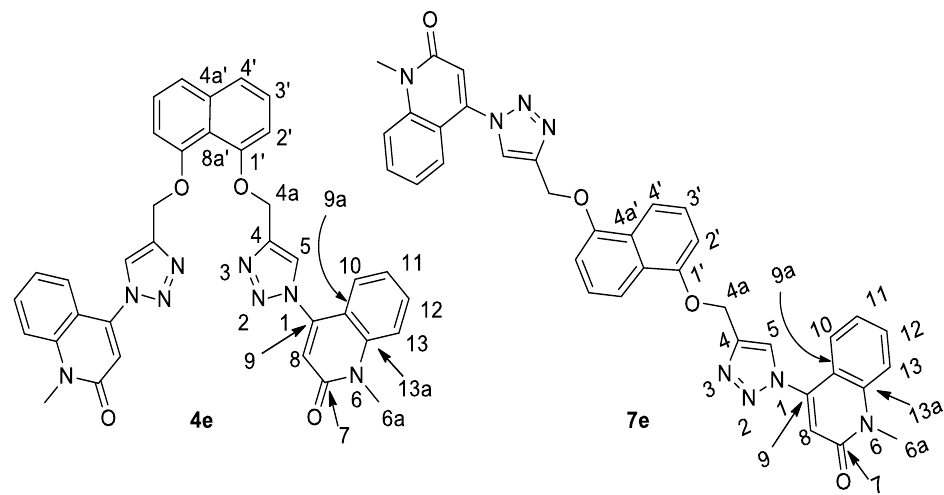
Figure 5. Structure of 1,5-bis(prop-2-yn-1-yloxy)naphthalene ( 6 ).